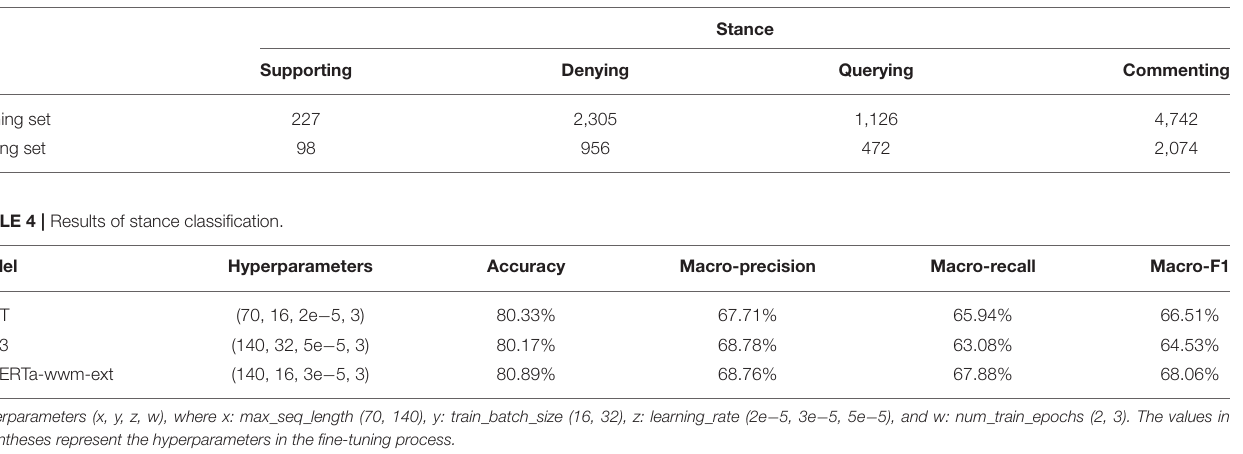
TABLE 3 | Label distribution of the training and testing sets.